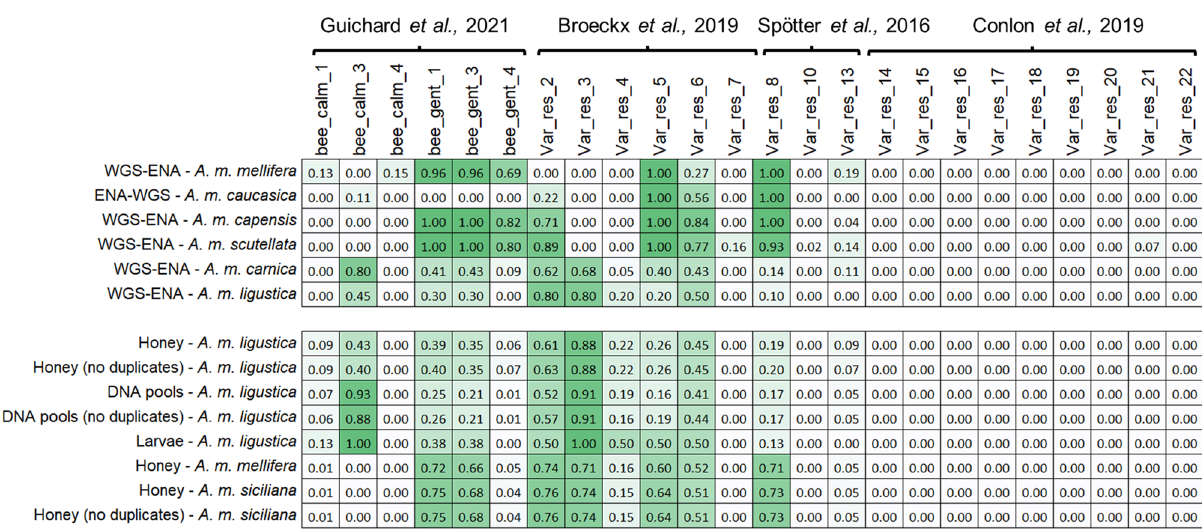
Figure 3. Average frequency of the alternative allele (from 0 to 1, i.e 0% to 100%) of the 24 Apis mellifera DNA markers linked to calmness, gentleness and varroa resistance (reference papers are provided and mentioned in the text). The colour of the box (from pale to dark green) mirrors the allele frequency. Results are reported both including and excluding duplicate